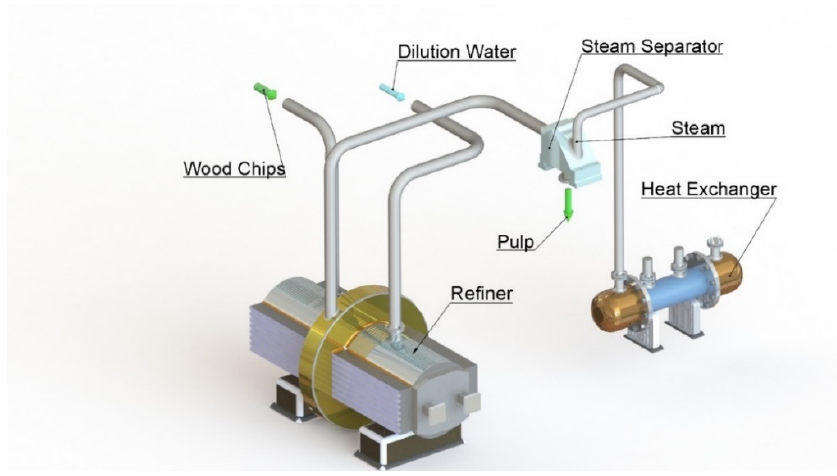
Figure 1. A single-disc refiner connected to the heat recovery unit (studied case).